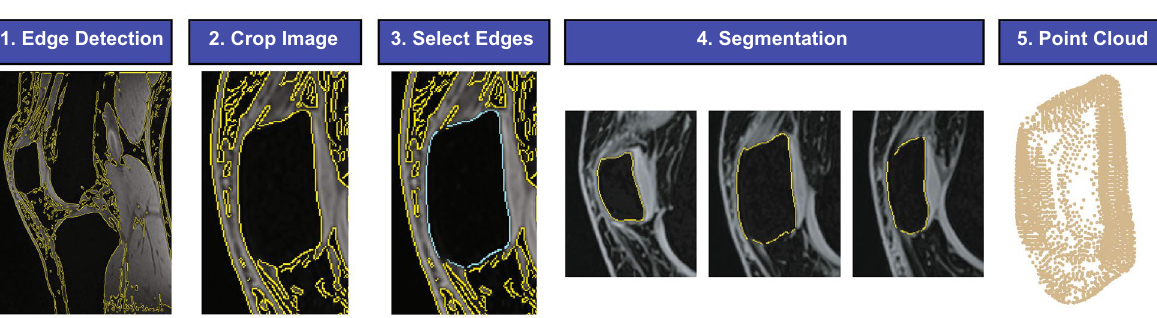
Figure 4. Semi-automatic segmentation steps for isolating bone from either MR or CT images. ( 1 ) A Canny edge detection filter is used to identify all edges in each image. The edges are overlaid in yellow on each image. ( 2 ) The image volume is cropped around the bone of interest (patella). ( 3 ) On a single starting image slice, the user selects the edges of the patella previously identified by the Canny filter. The selected edges are highlighted in cyan. ( 4 ) This starting slice is then used to determine the edges nearest these points in adjacent slices in the image volume. The user can remove stray edge points in any slice before proceeding. ( 5 ) The identified bone edges are converted into a three-dimensional point